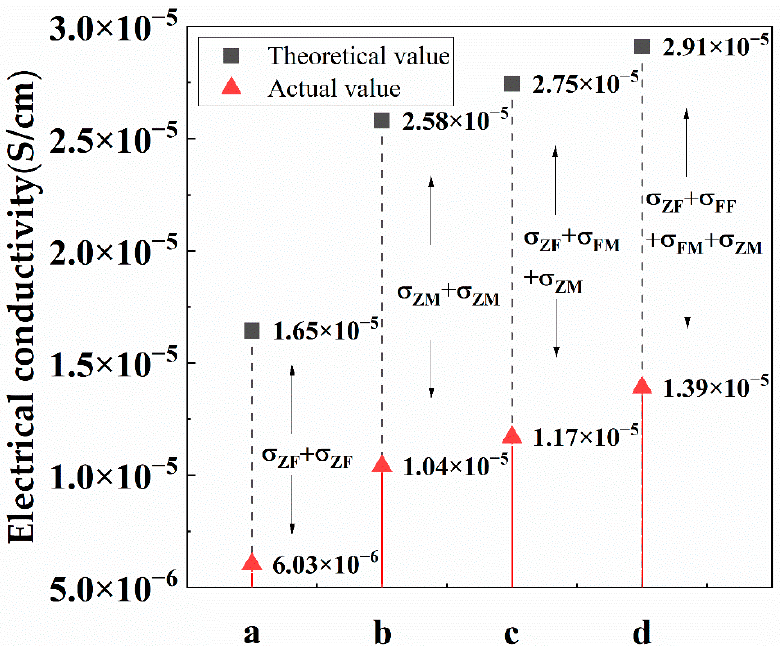
Figure 5. Electrical conductivities of multilayer membranes in the theoretical value and actual value.